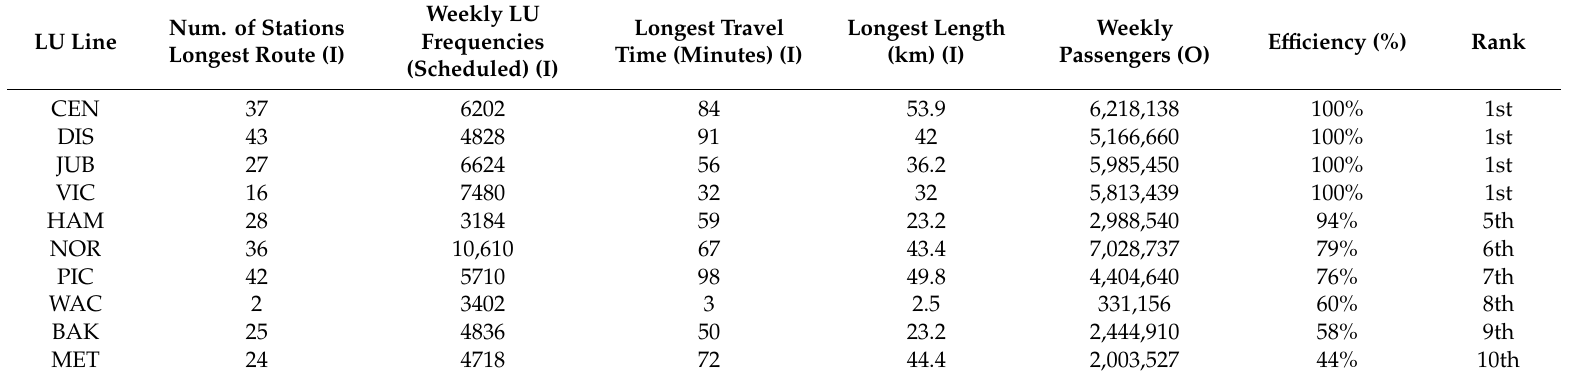
Table 10. Results of the URT lines DEA model of LU with two additional input parameters.